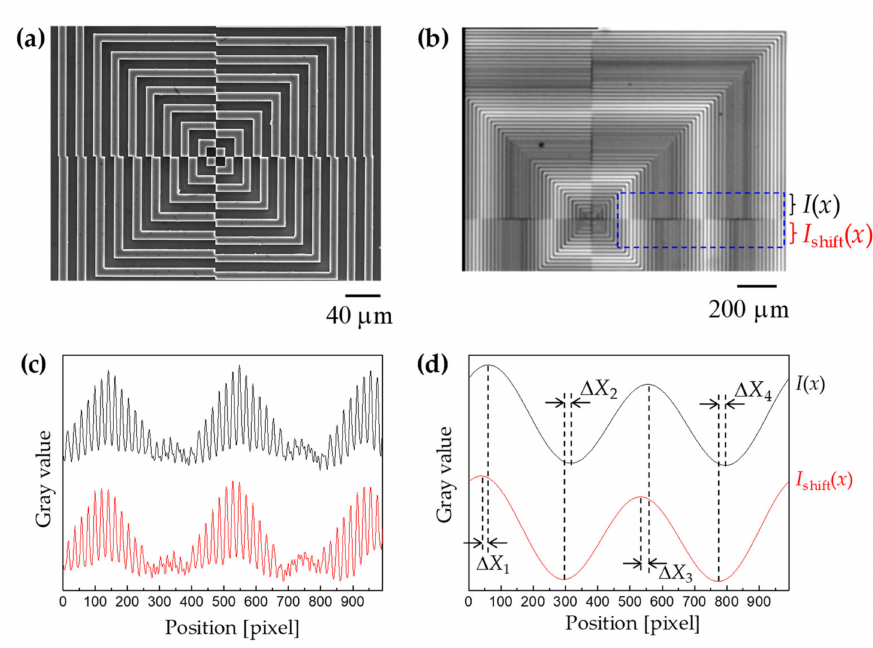
Figure 8. ( a ) Scanning electron microscope (SEM) image of the centrosymmetric grating mark fabricated on the Si wafer; ( b ) IR image of the moir é fringe pattern for the Si / Si wafer bonding; ( c ) the intensity distribution as a function of position along x -direction in the blue rectangular region; ( d ) the moir é shift in x -direction ( ∆ X , the average value of ∆ X 1 ~ ∆ X 4 ) was measured by analysis of the moir é fringes after fast Fourier transform (FFT) and low pass filter.